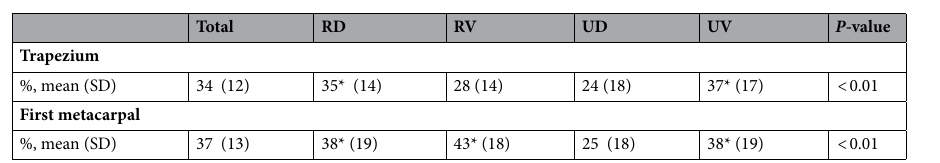
Table 2. Percentage of the high-density areas in each region at articular surfaces of the trapezium and first metacarpal. RD radial-dorsal region, RV radial-volar region, UD ulnar-dorsal region, UV ulnar-volar region. * P < 0.05 versus